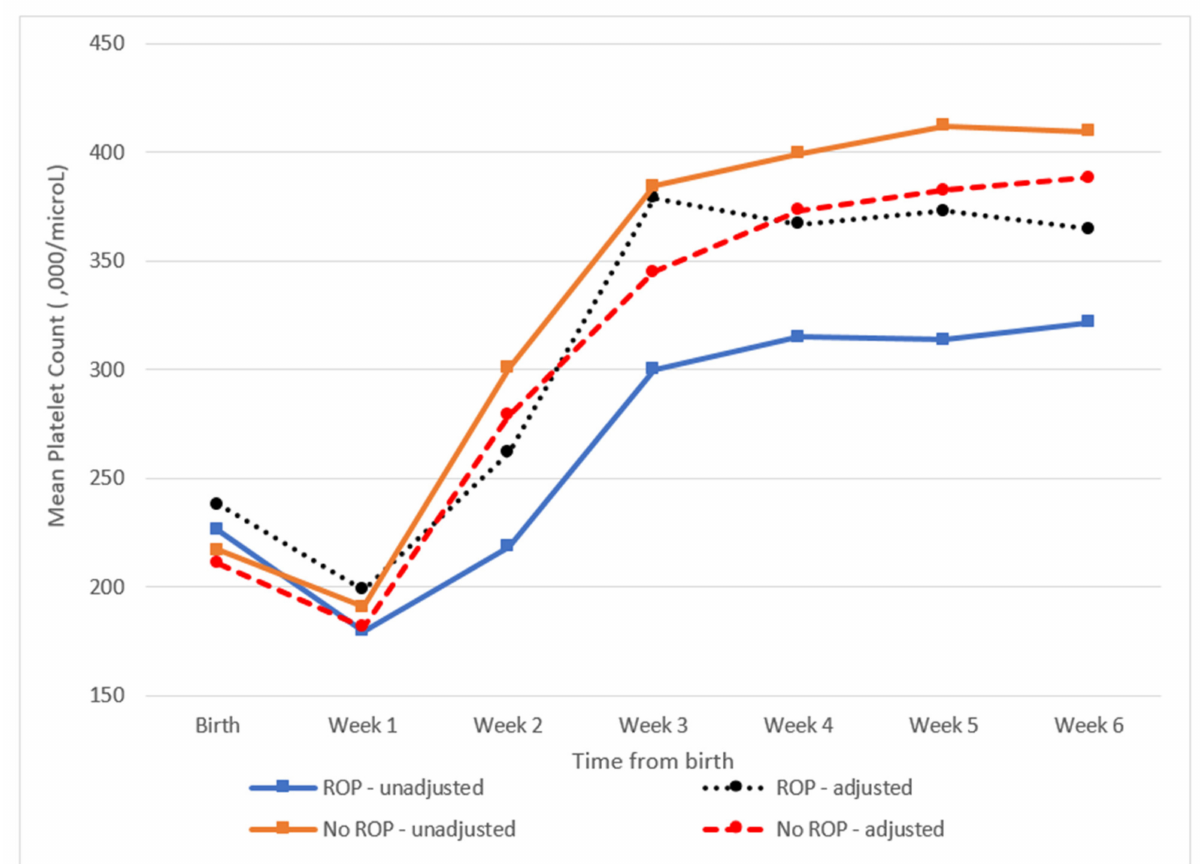
Figure 1. Mean platelet count in groups with and without retinopathy of prematurity (ROP) from birth to week 6 of life pre-and postadjustment for confounders (culture-proven sepsis, blood transfusion and bronchopulmonary dysplasia). This graphical depiction of the weekly mean platelet count in infants with and without ROP demonstrates that the difference between the two groups disappears after adjusting for